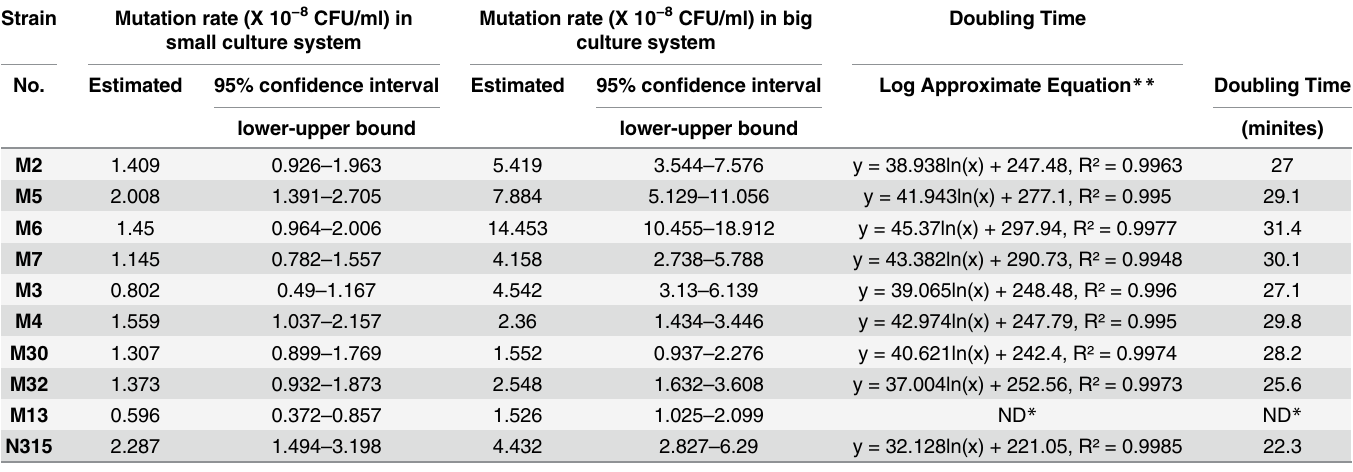
Table 3. Mutation rate and doubling time of strains used.